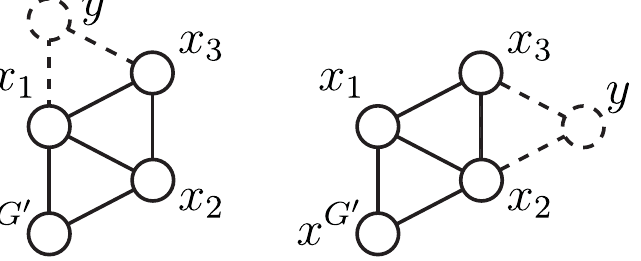
Fig 4. Extensions of the k − 1-node graphlet G 0 to G a . G 7 can be extendedto G 24 by attaching y to either x 1 and x 3 or to x 2 and x 3 , hence E ¼ ff x have one common neighbourin G 0 , so c ( E G 0 ) = 1 and